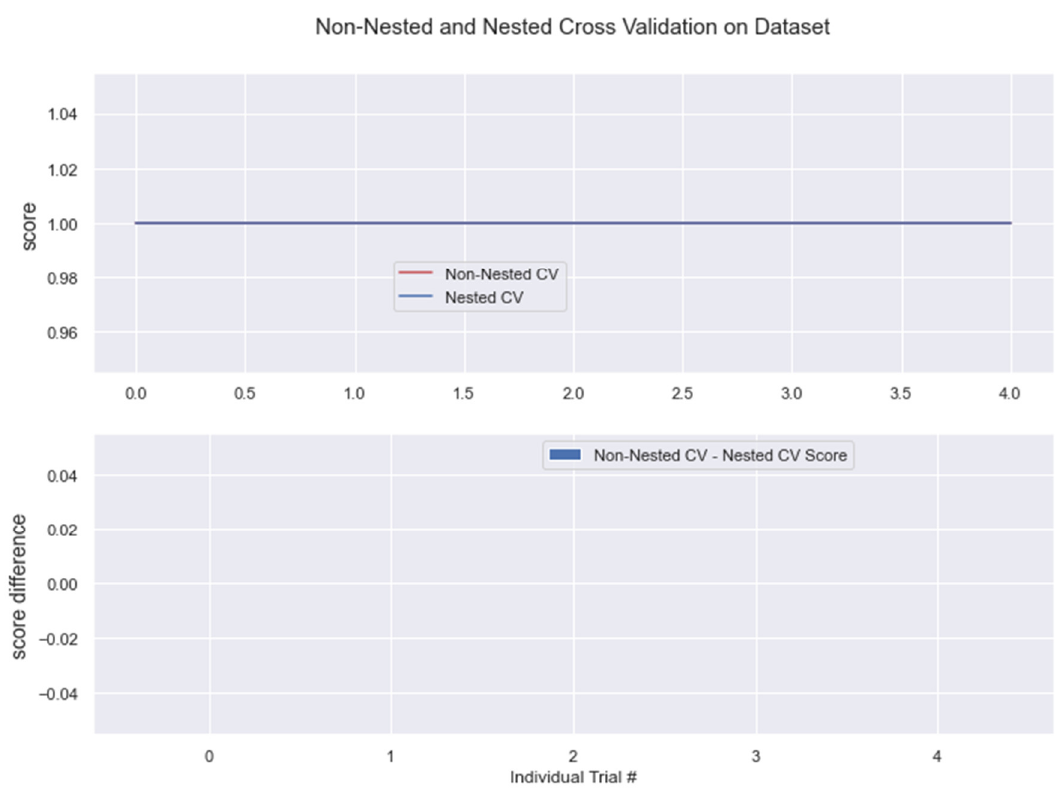
Figure 20. Non-Nested and Nested cross-validation on RFC algorithm. Note: All other algorithms (KNN, BC, GBC) have the same non-nested and nested cv scores. This is represented in the below figure.